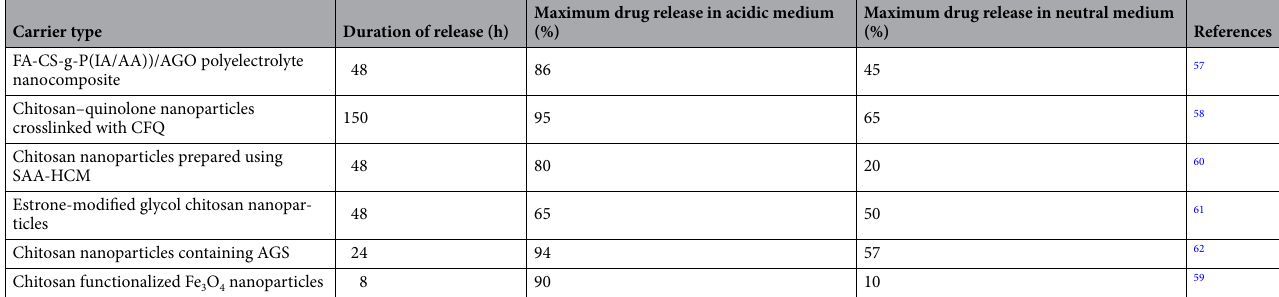
Table 1. Maximum drug release in acidic and neutral medium and release time of some pH-sensitive nano-